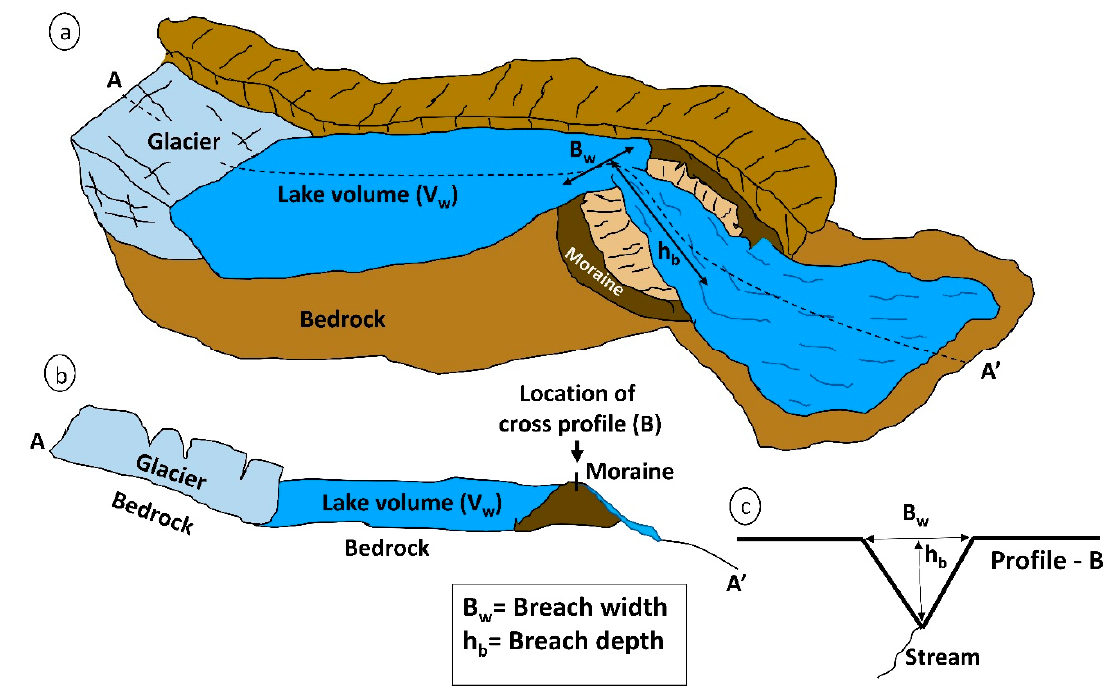
Figure 3. Schematic showing ( a ) a moraine-dammed glacial lake showing breach width ( Bw ) and breach depth ( h b ); ( b ) valley longitudinal profile along AA’; ( c ) moraine dam post-failure cross profile (see ( b ) for location). Table 1. Breach parameters for scenario modeling calculated based on Froehlich